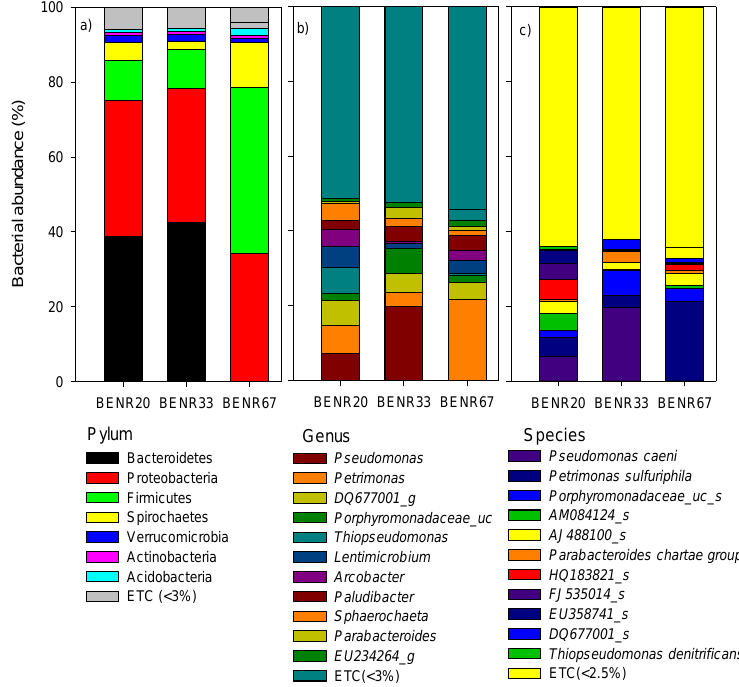
Figure 6. Relative abundance of bacterial communities depending on the electrostatic field strength: ( a ) phylum, ( b ) genus, and ( c ) species.